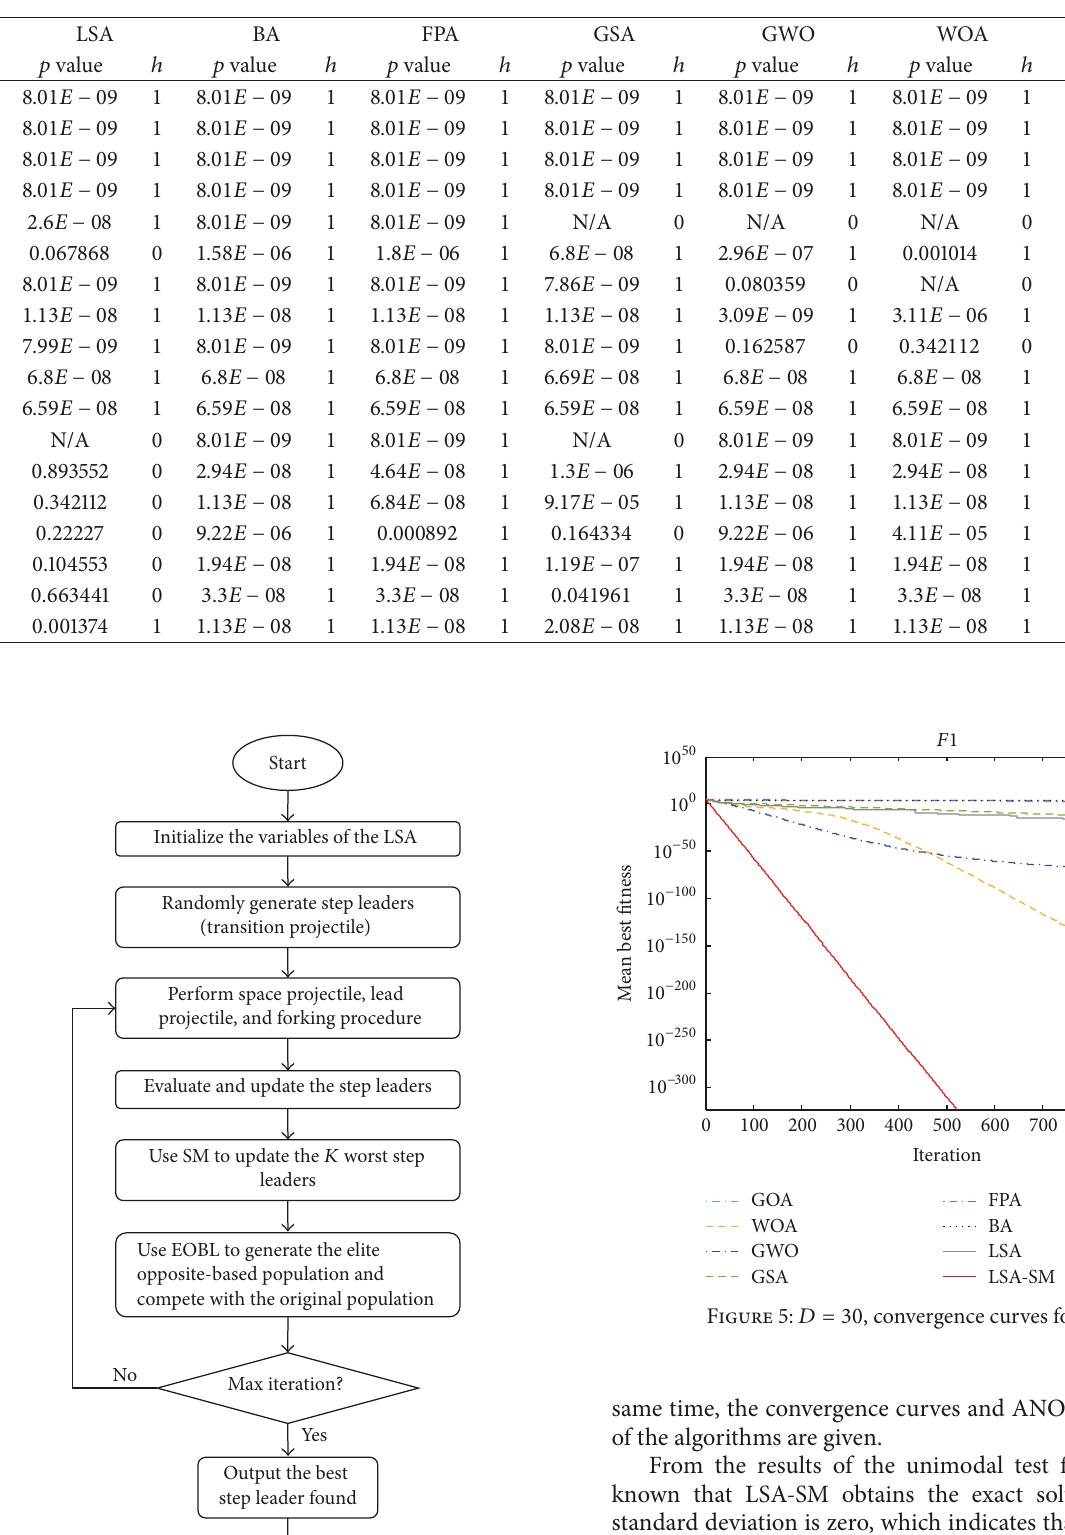
Table 7: Statistical comparison between LSA-SM and the other seven algorithms.